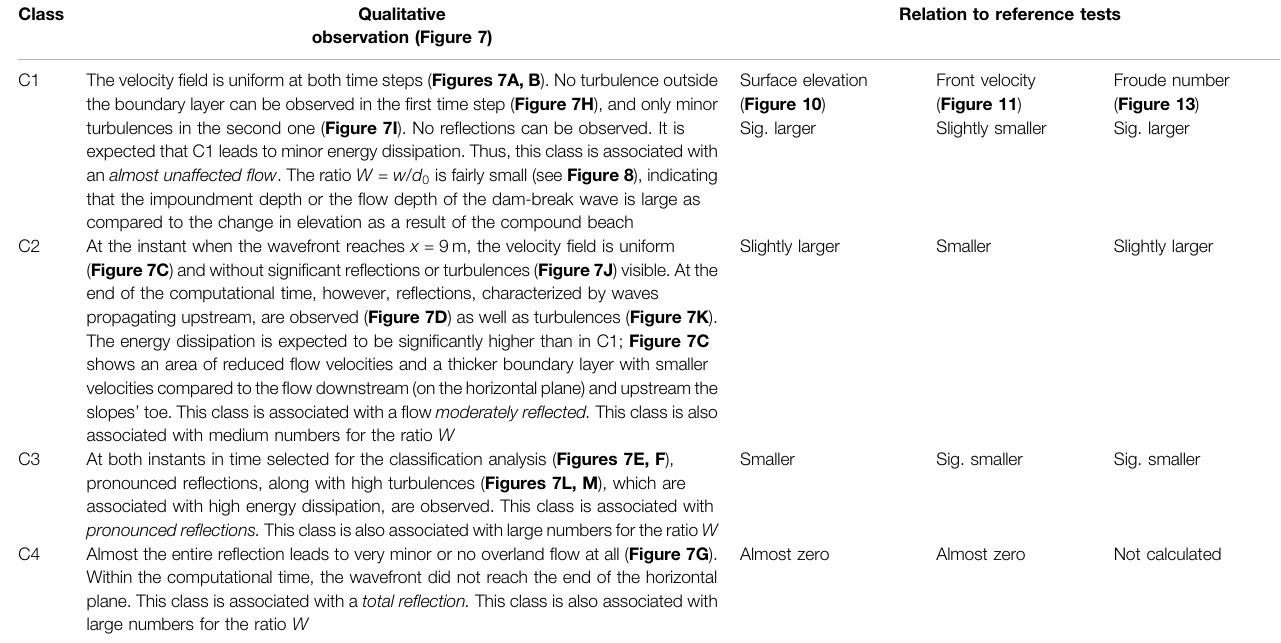
TABLE 3 | Class de fi nition and relation of fl ow features to reference